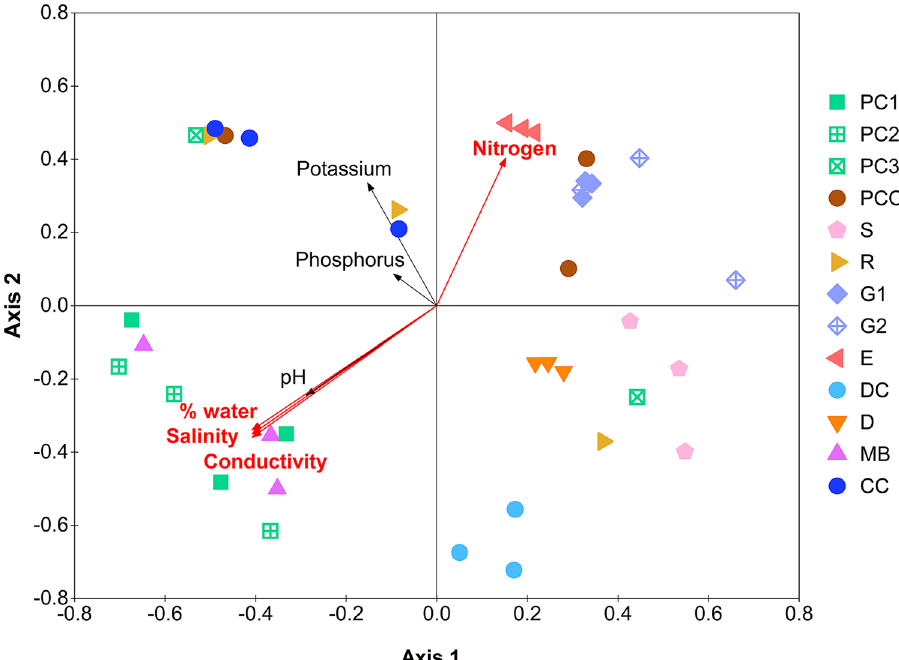
Figure 5. Relationship among bacterial communities via NMDS constructed from thetayc distance coefficients among quantitative microbiota (stress value = 0.15, R 2 = 0.86), and Pearson’s correlation with nutrients and physiochemical properties (AMOVA, p < 0.001). A vector direction and length represented the direction and strength of that nutrient or physiochemical factor to the communities. A red arrow with red font indicated a statistically significant correlation (p <